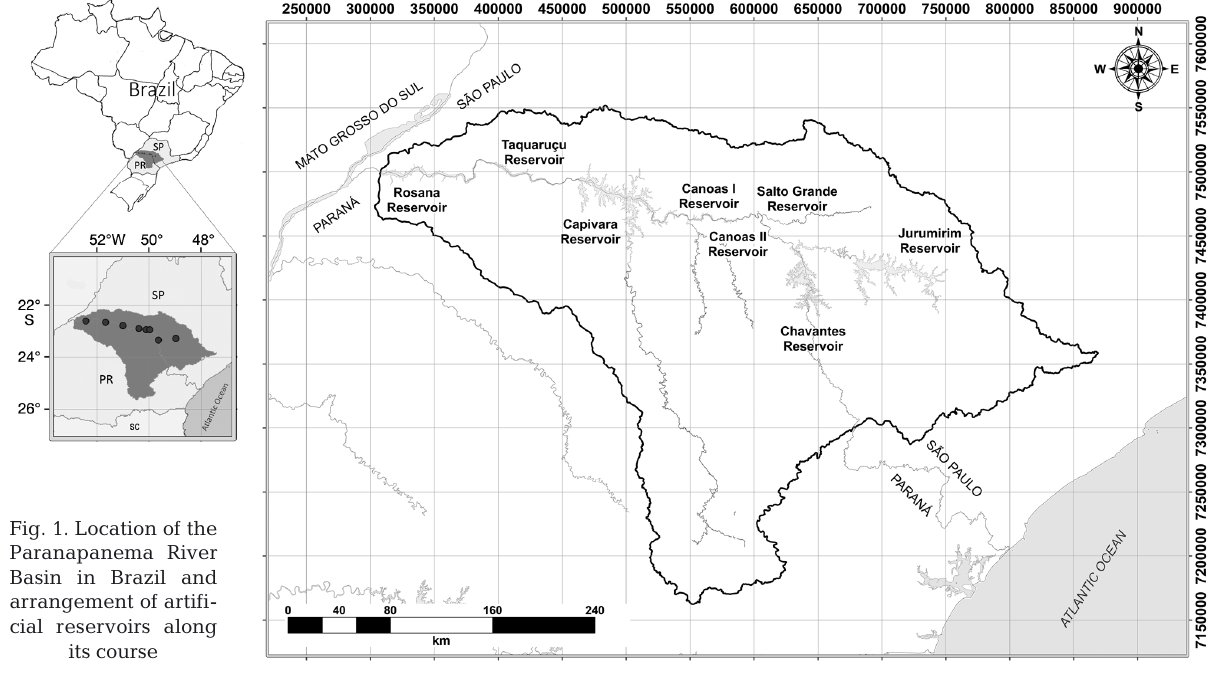
Fig. 1. Location of the Paranapanema River Basin in Brazil and arrangement of artifi- cial reservoirs along its